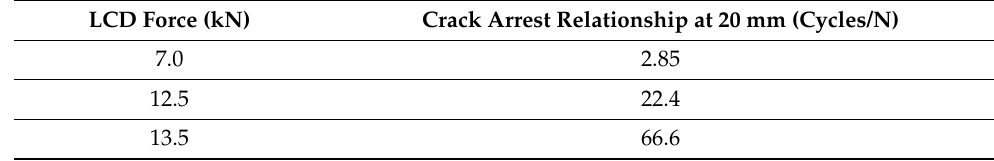
Table 3. Crack arrest relationship for different LCD